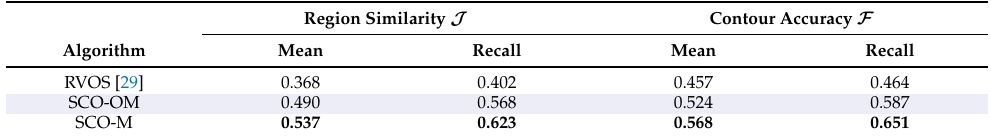
Table 8. Comparison of the proposed SCO algorithm with the conventional unsupervised algorithms on the validation set in DAVIS2017.